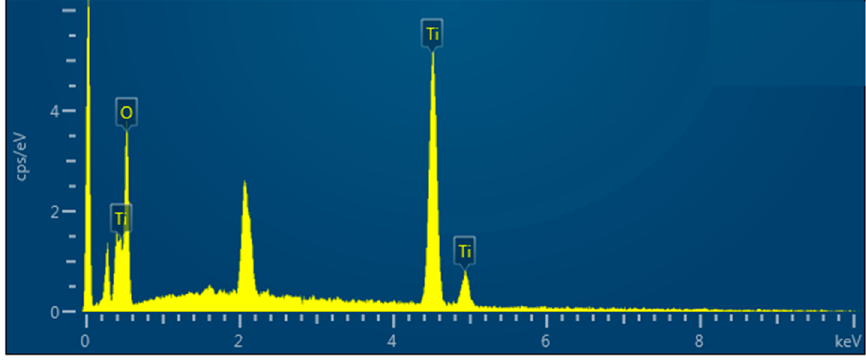
Figure 4. X-ray energy spectrum analysis of MPCMs.